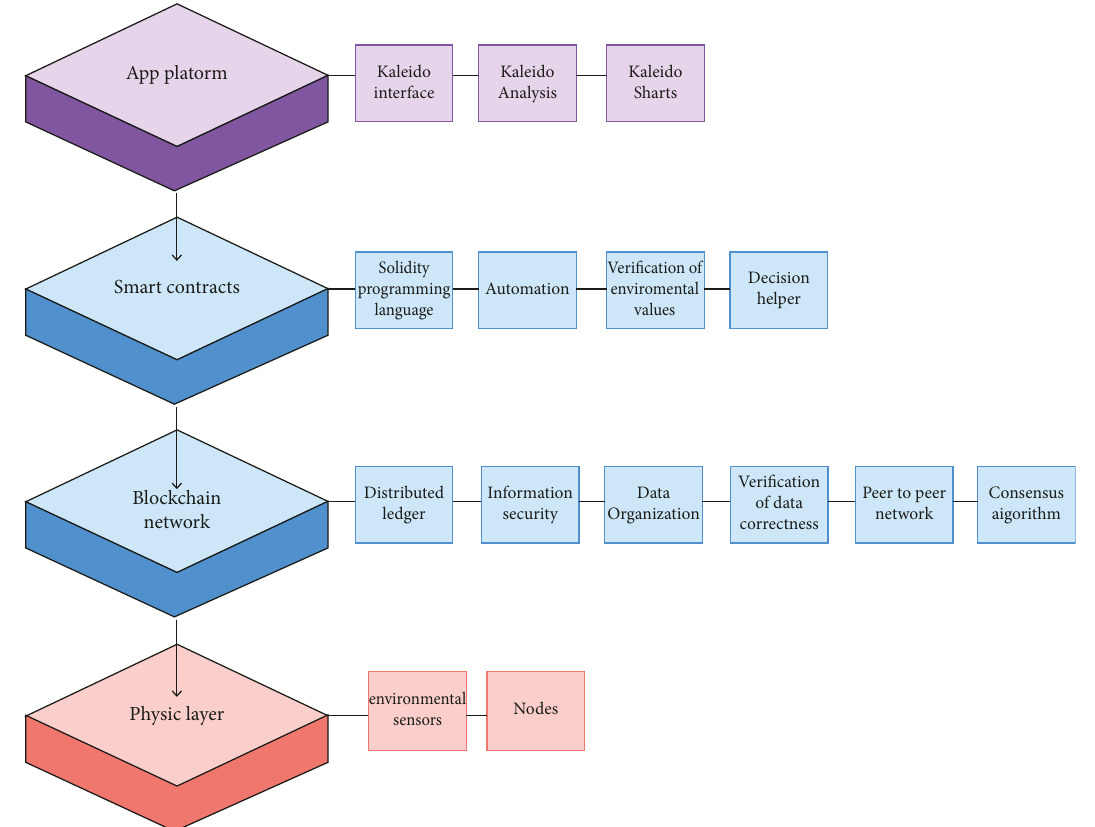
Figure 5: The technical stack of the proposed